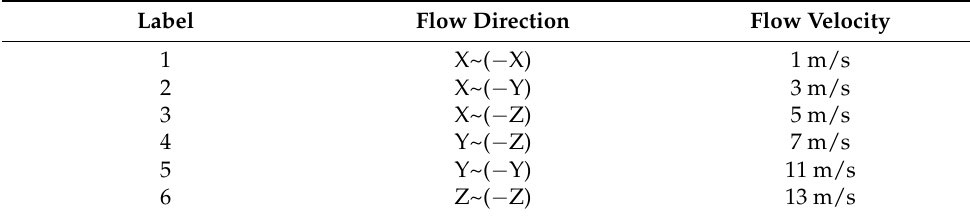
Table 2. Parameter settings for the seawater fluid space model.